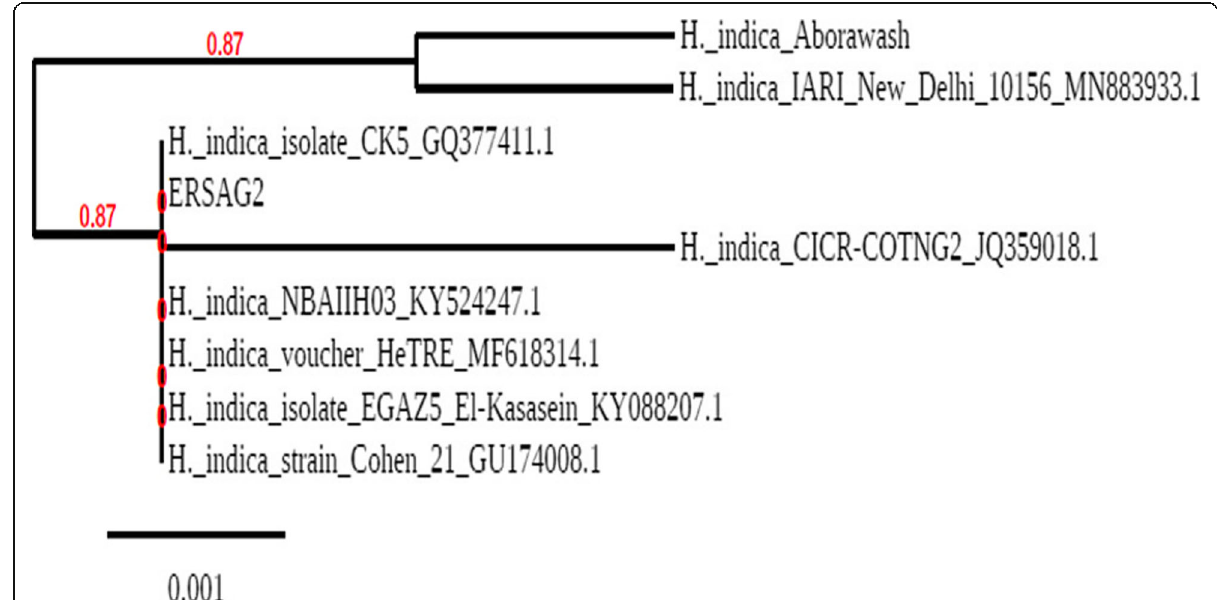
Fig. 2 Maximum likelihood ITS phylogenetic trees of H. indica species using ITS sequence. Based on nucleotide sequences of H. indica ( Heterorhabditis indica Aborawash and ERSAG2) and reference strains (alignment length approximately 700 bp using phylo_tree analysis (Phylogeny.fr.